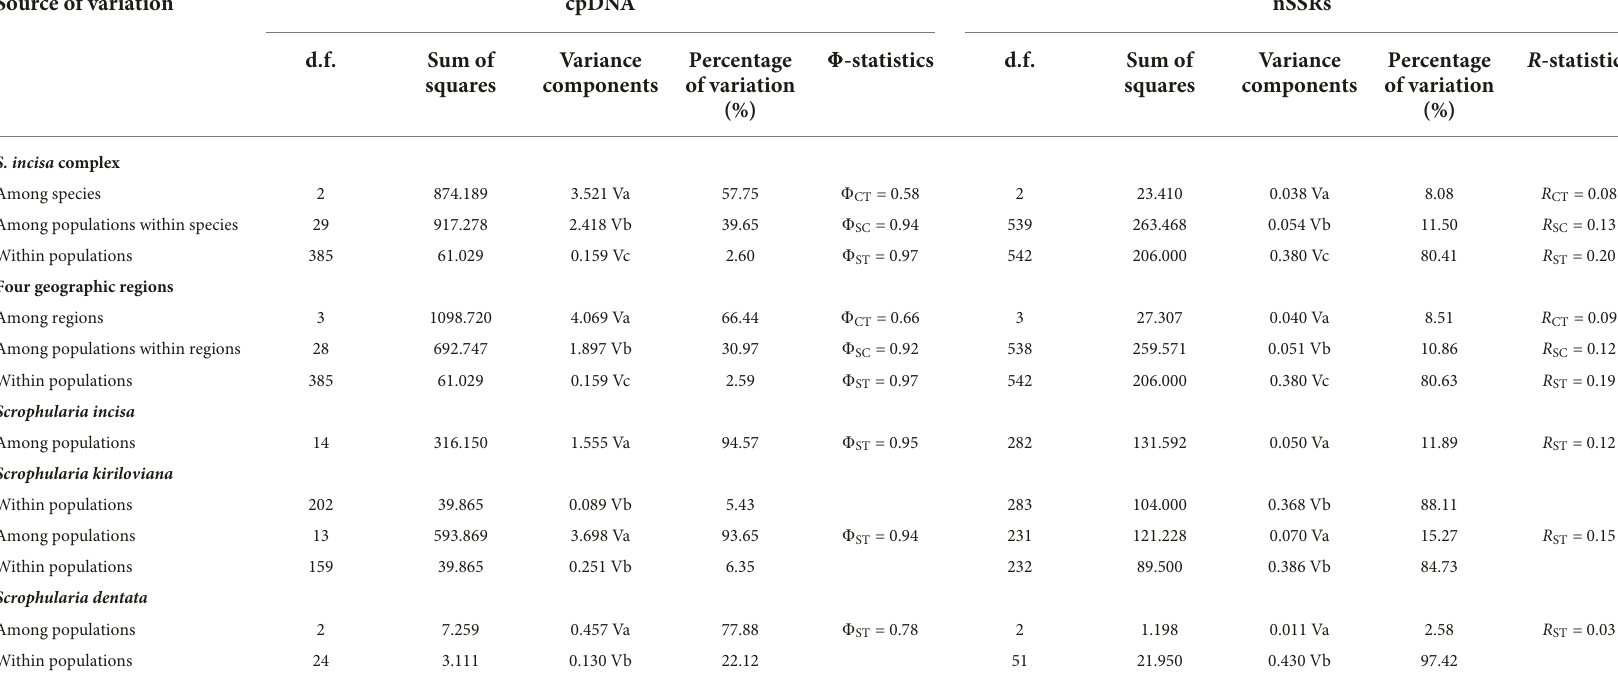
TABLE 1 The analysis of molecular variance (AMOVA) for cpDNA data and nSSR data among geographic regions and populations of Scrophularia incisa complex. Source of variation cpDNA nSSRs d.f. Sum of Variance Percentage squares components of variation